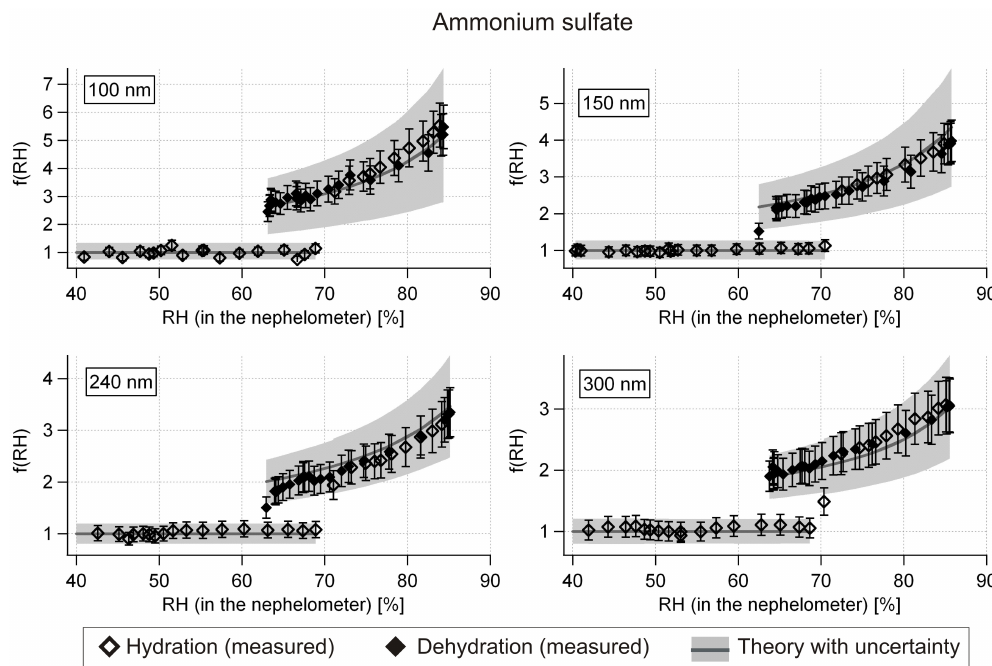
Fig. 3. f (RH) vs. RH in the nephelometer of ammonium sulfate particles with a dry diameter of 100, 150, 240, and 300nm. The grey lines represent the predicted f (RH) with corresponding uncertainties. Black open diamonds show the measured f (RH) of hydrating aerosols, while black closed diamonds represent dehydrating aerosols. The phase transition at deliquescence occurred at RH=79.9% at the most humid location in the system (RH 3 ).